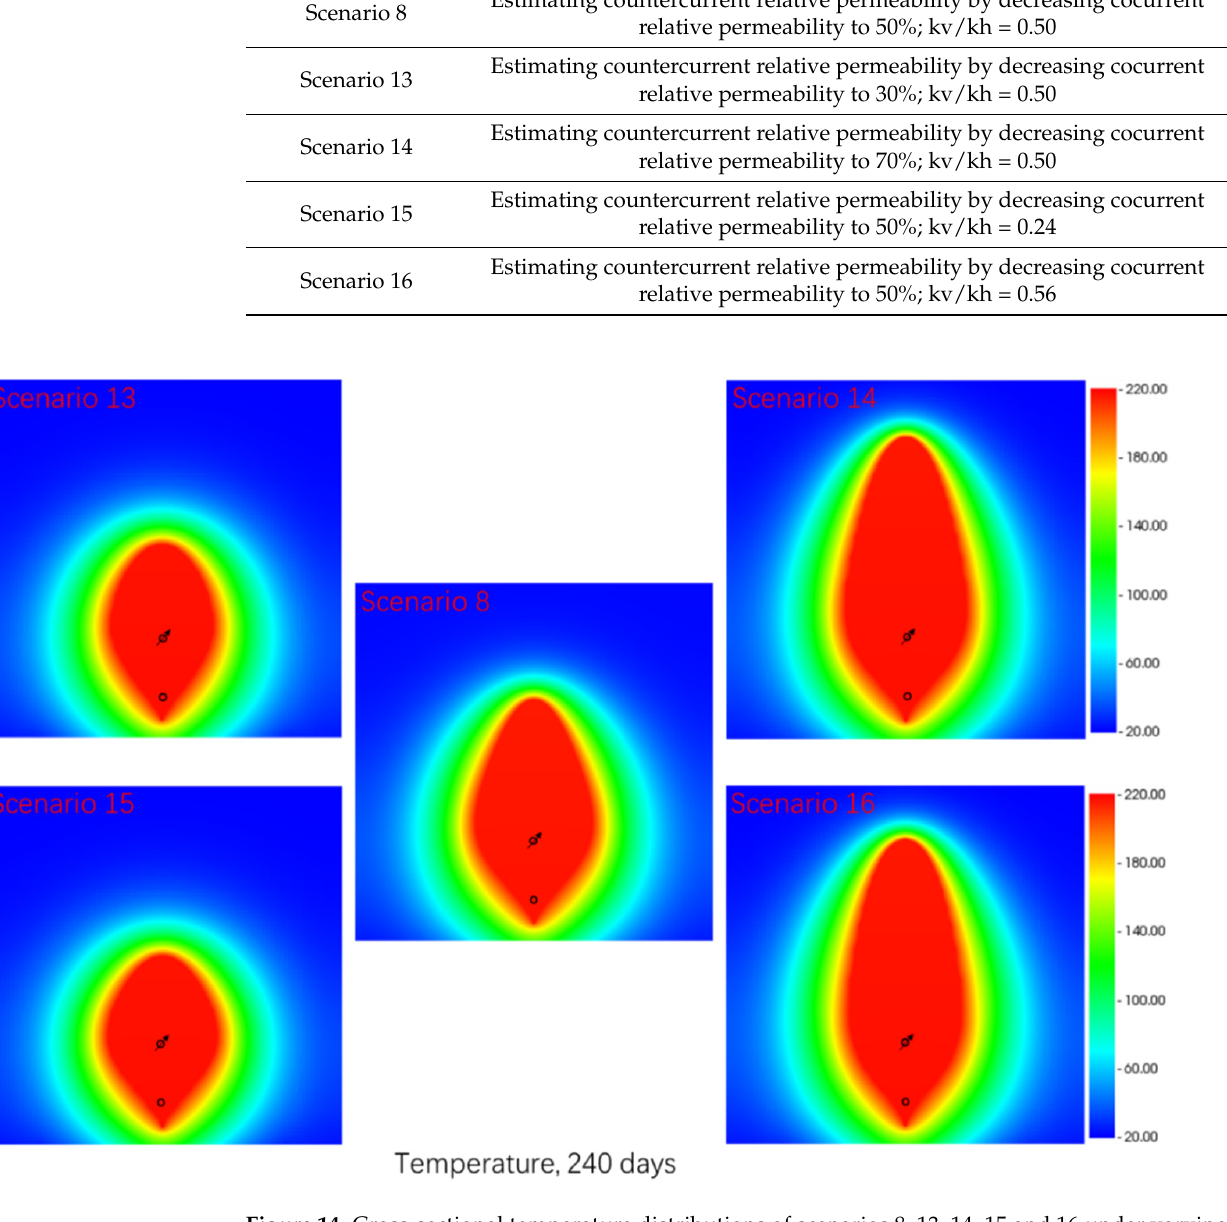
Figure 15. Cumulative oil production of scenarios 8, 13, 14, 15 and 16 under varying countercurrent relative permeability values and vertical permeabilities using kv/kh ratios. 0